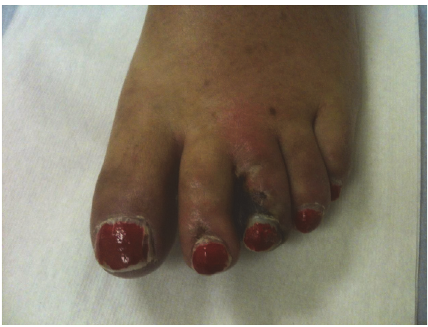
Figure 1: Left foot of a 59-year-old patient presenting to rheumatol- ogy